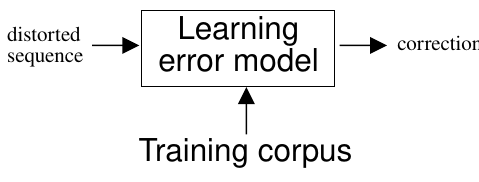
Figure 6. Spelling correction with learning error